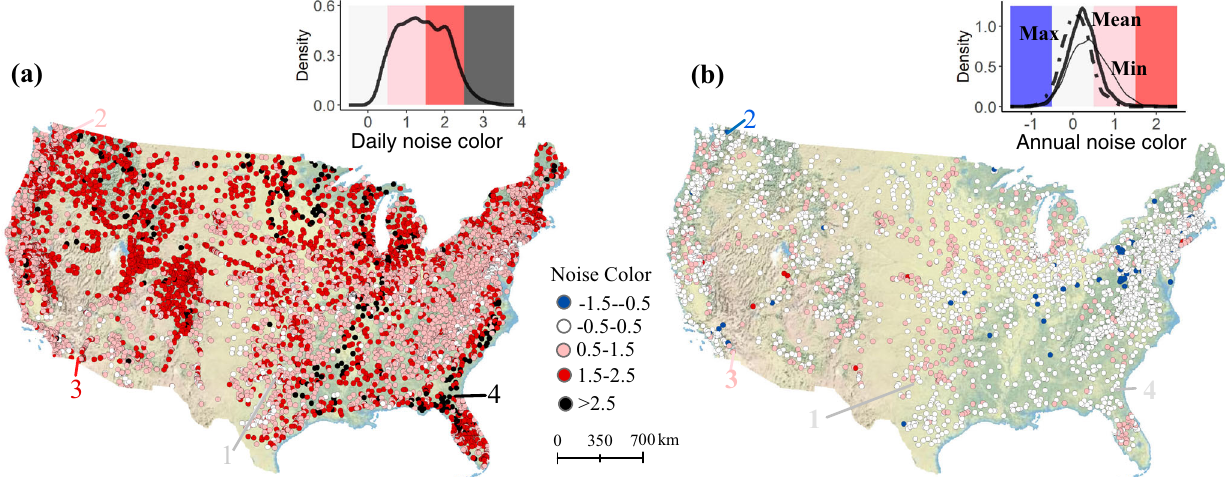
Fig. 1 | Observed patterns of fl ow noise color across 7504 (for daily data) and 2594 stream gages (for annual data) across the conterminous United States. In a and b we show the spatial distribution of daily and annual fl ow noise color respectively, together with their density distributions (for annual fl ow noise color, we show the mean, minimum, and maximum annual fl ow; obtained from the average, minimum, and maximum daily fl ows in a year). Four different sites are shown, selected to illustrate arangeof fl ow regimes: site 1,USGSgage